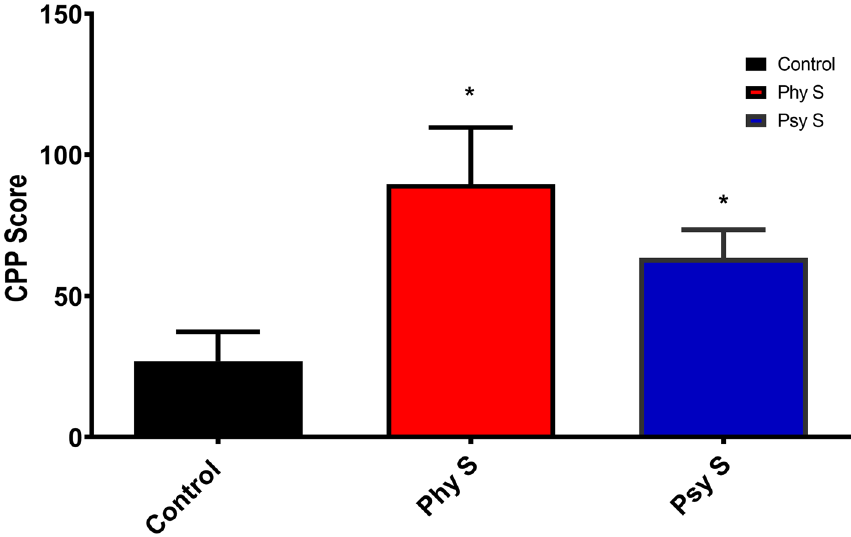
Figure 5. Assessment of the effect of PS on conditioned place preference (CPP) score of the offspring. CPP score is defined as the difference in time spent in the non-preferred chamber on post-conditioning day and the time spent in the non-preferred chamber on pre-conditioning day. Data are displayed as Mean ± SEM. Phy s: physical stress, Psy s: psychological stress, * ( p < 0.05) compared to the control